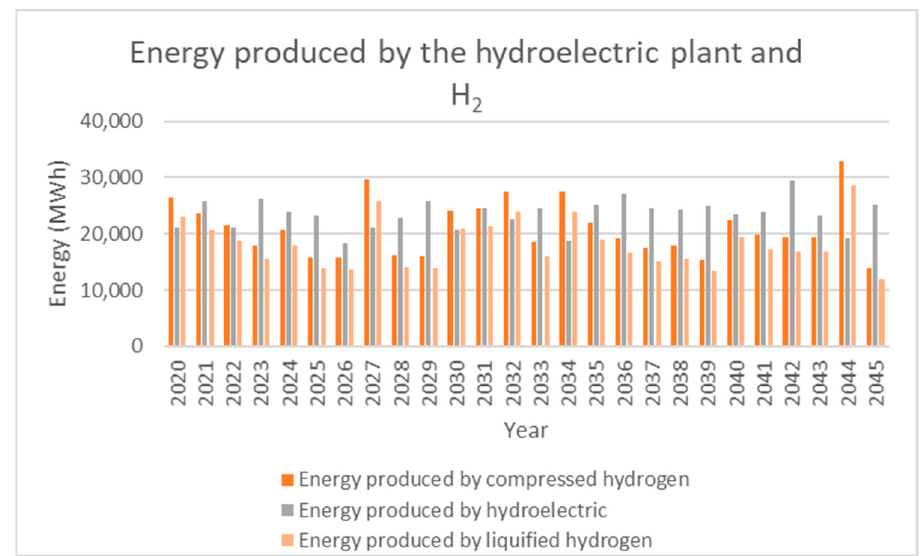
Figure 16. Energy produced by the hydroelectric plant and H 2.